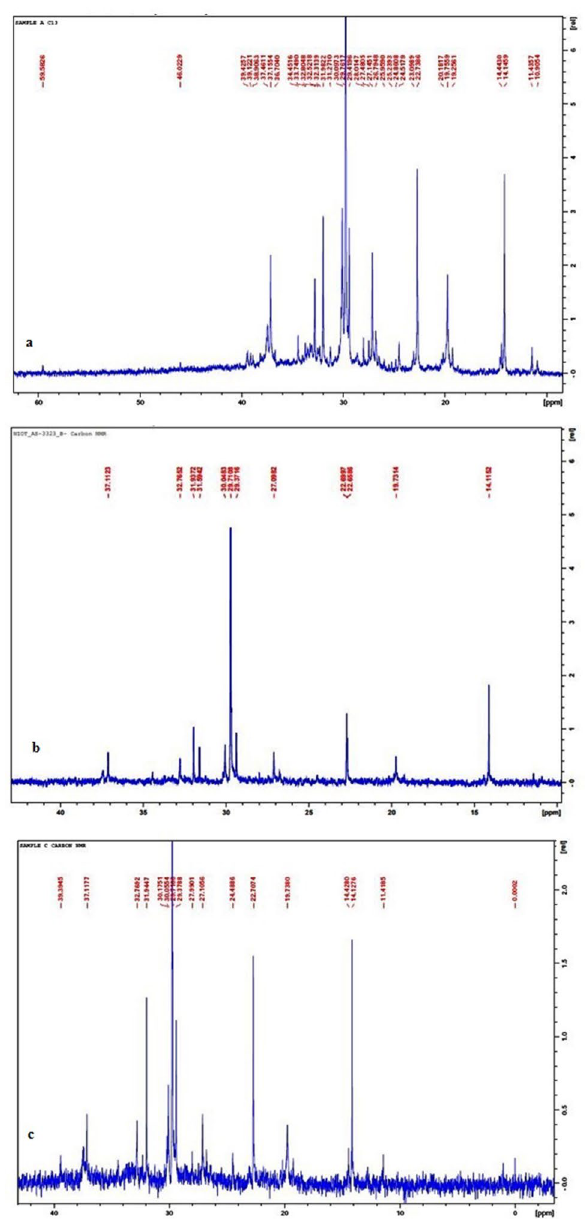
Figure 6. 13 C NMR analysis ( a ) SE oil, ( b ) degraded SE oil at 0.1 MPa and ( c ) degraded SE oil at 10 MPa pressure